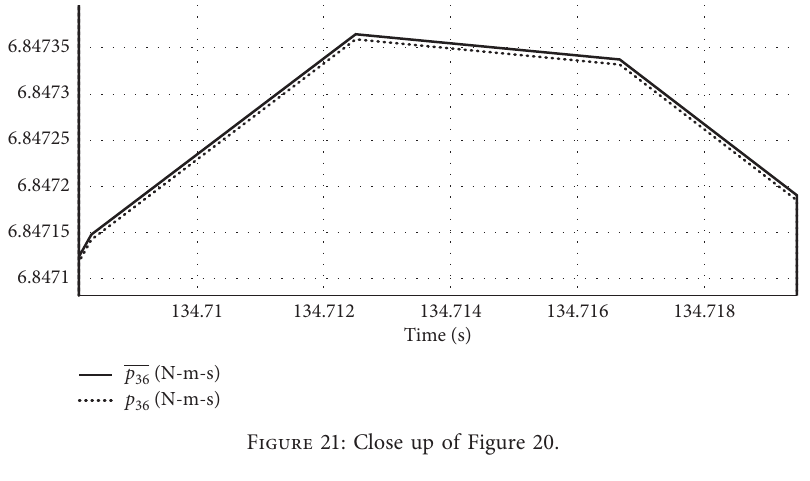
Figure 21: Close up of Figure 20.